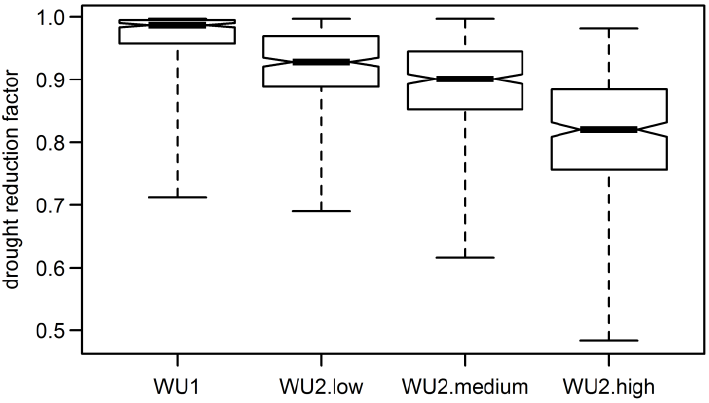
Figure 5. Box plots (lower whisker = lowest extreme, lower hinge = first quartile, median,